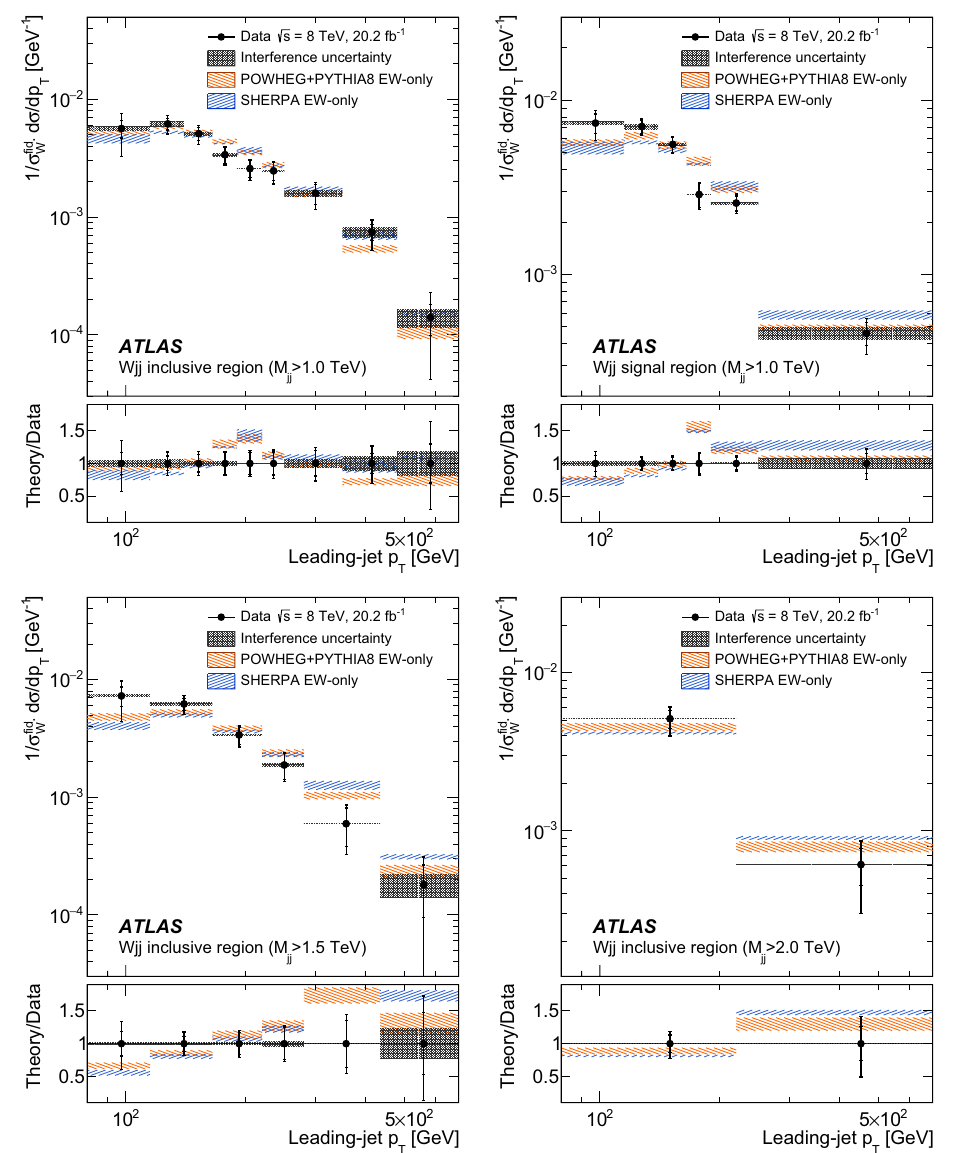
Fig. 25 Unfolded normalized differential EW W jj production cross sections as a function of the leading-jet p T for the inclusive fiducial region with three thresholds on the dijet invariant mass (1.0, 1.5, and 2.0 TeV), and for the signal-enriched fiducial region with a minimum